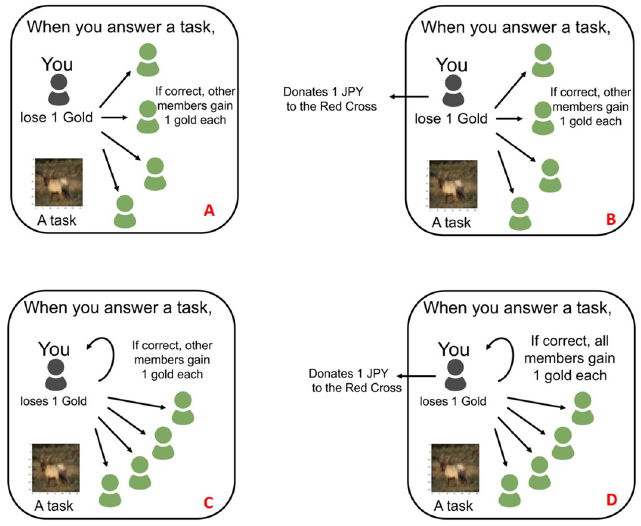
Fig 1. Punch images shown as instructions to each of the four treatments. Matrix showing the instructions to participants depending on their treatment. Starting from top left in clockwise rotation: Treatment A, B, C, D.